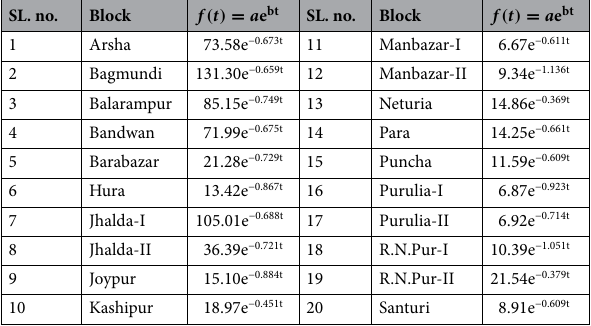
Table 4. Exponential decay model with estimated parameter values for each